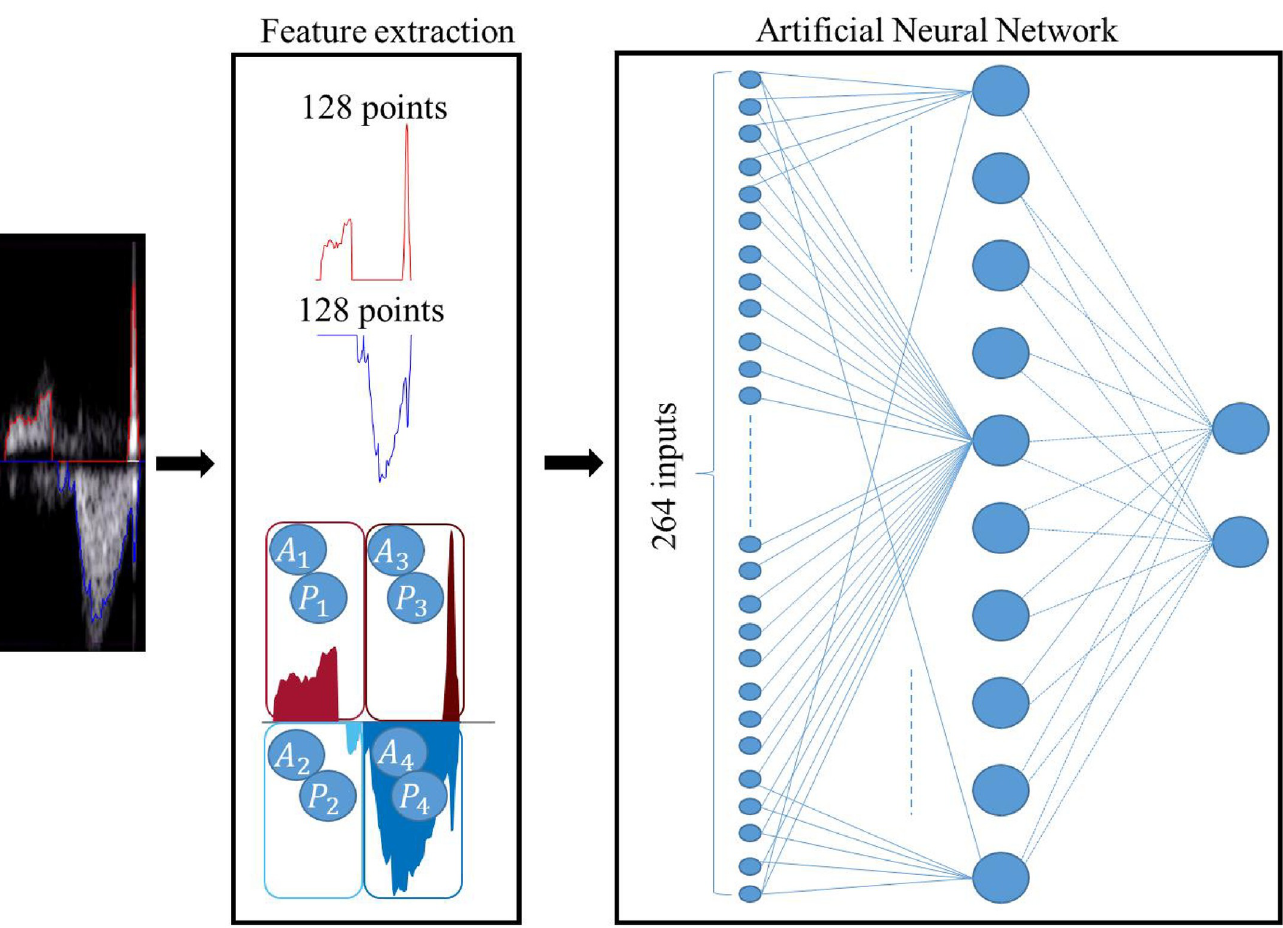
Fig 5. Classifier model. From left to right, the features are extracted from a portion of the PWD signal (in this case that representing a meaningful beat). The features include 128 samples from the upper envelope (red line), 128 samples from the lower envelope (blue line), four area features ( A i ), and four pixel-based features ( P i ). The ANN is fed by this 264-element feature vector, and consists of one hidden layer with 10 hidden neurons and two output nodes for binary